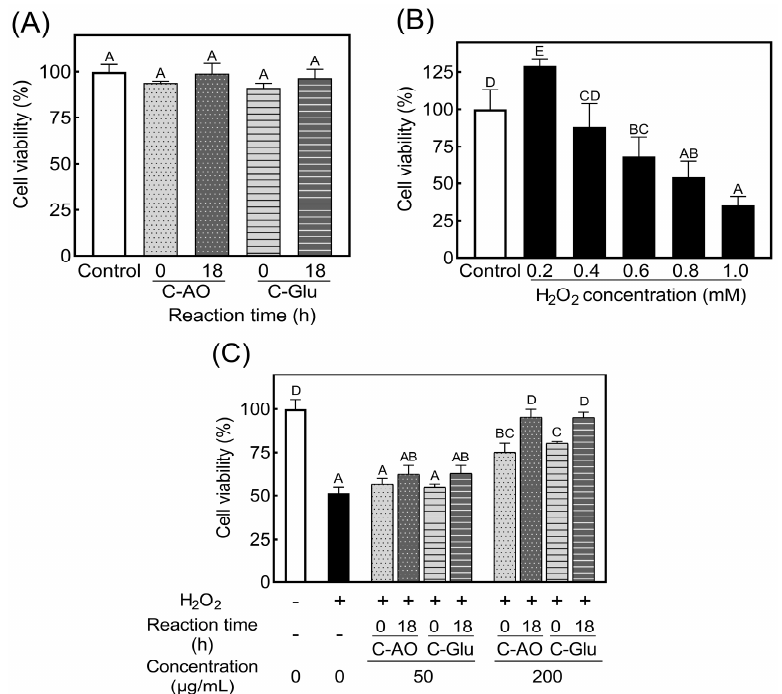
Figure 5. Cytoprotective effects of C − AO and C − Glu on oxidative damage in RAW 264.7 cells. ( A ): Cytotoxicity of glycated collagen. Pepsin–trypsin digested C − AO and C − Glu with glycation for 0 h and 18 h were added to RAW 264.7 cells, respectively. ( B ): Oxidative damage was induced by 0.2–1.0 mM H 2 O 2 in RAW 264.7 cells. ( C ): The C − AO and C − Glu against cell oxidative damage; 50 or 200 µg/mL C − AO or C − Glu (0-h or 18-h glycation) were added to RAW 264.7 cells and stimulated by 0.8 mM H 2 O 2 . Data from additive-free cells were used as a control in calculating the cell viability of each experimental group. Bars with different letters indicate significant differences.